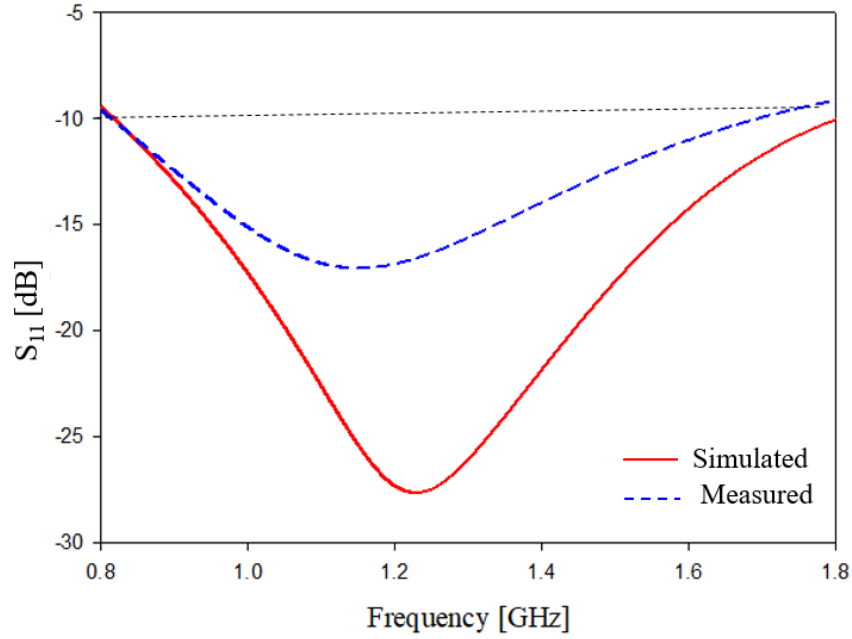
Figure 10. Numerical results antenna return loss S 11 .